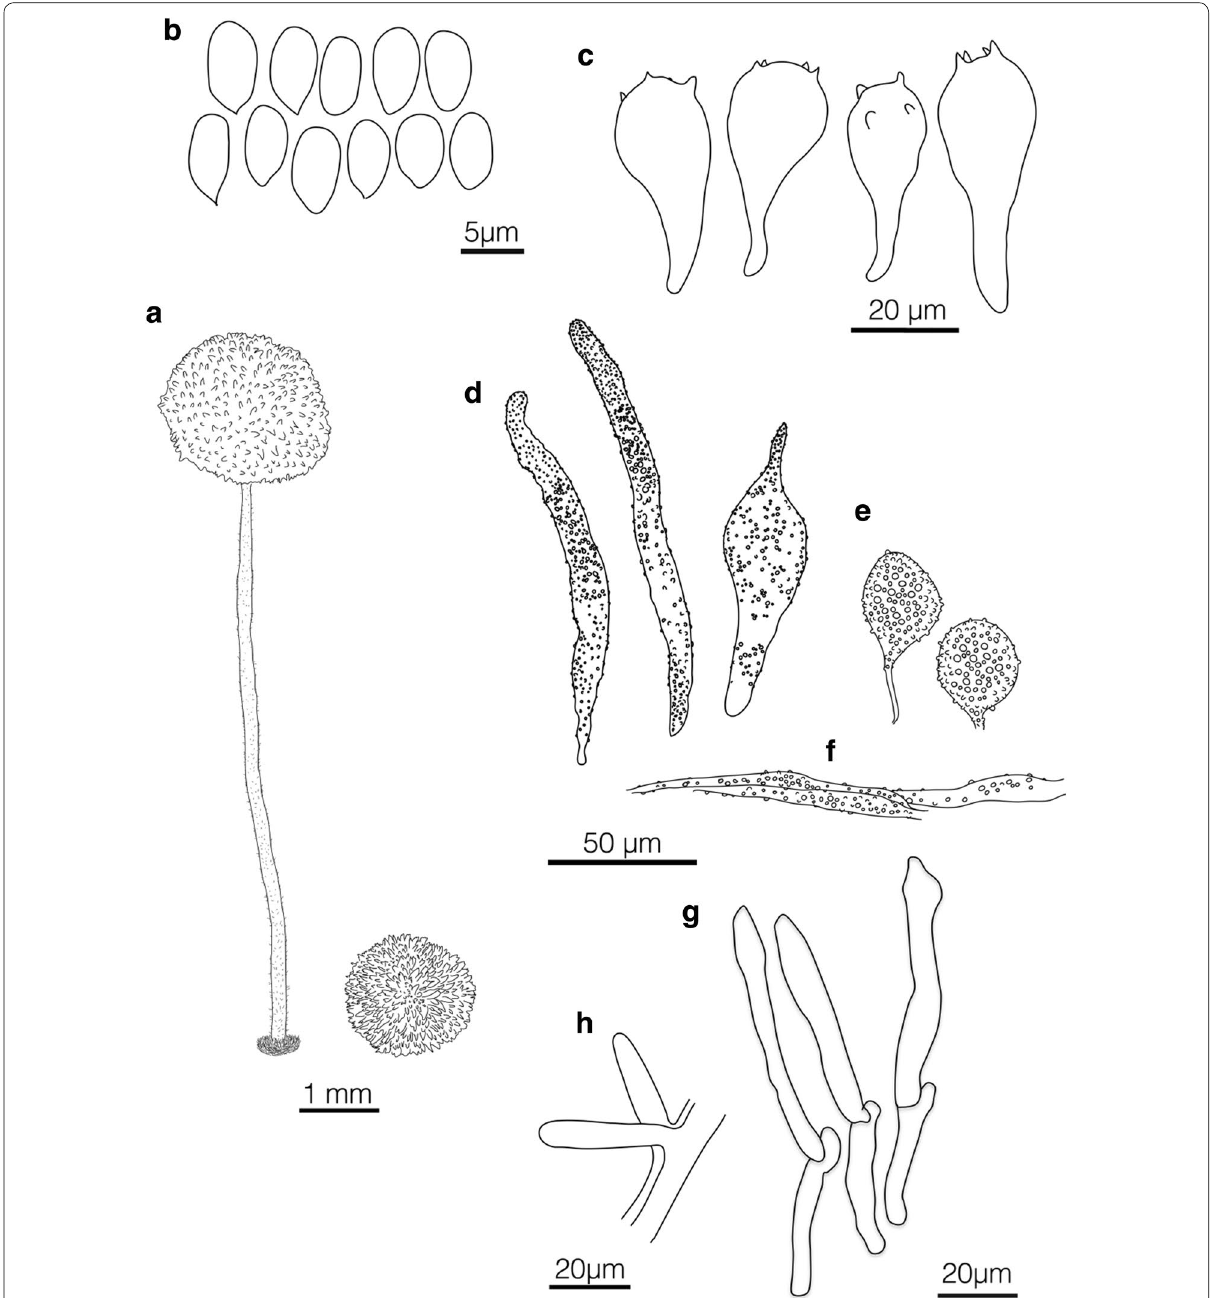
Fig. 2 Mycena albopilosa. a Basidiomata and primordia overlain with conspicuous white hairs. b Basidiospores. c Basidia. d Pileocystidia. e Acantho‑ cysts on pileus. f Pileipellis. g Cystidia on the basal disc. h